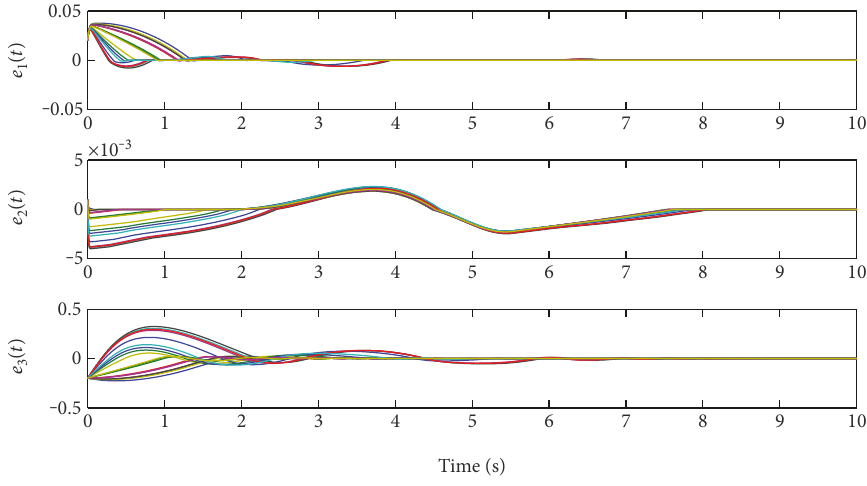
Figure 4: Closed-loop regulation of the steady state error.